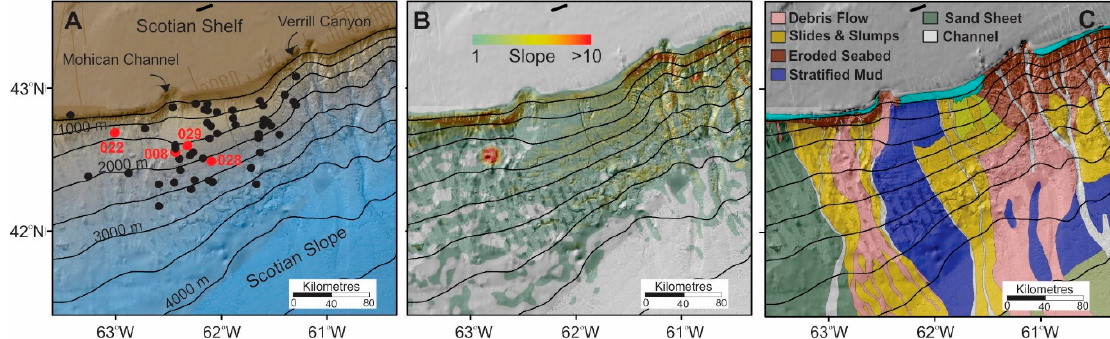
Figure 2. Study area: ( A ) Morphology and core site locations (dots) used in this study. Red dots indicate cores from which samples were extracted for triaxial shear testing. Isobaths are in meters water depth; ( B ) slope gradient derived from the GEBCO 2014 grid and averaged with a circular smoothing window with a radius of 12.5 km. Note that the general gradient of this central Scotian Slope region is on the order of 1–3; and ( C ) surficial geology derived from cores and interpretation of geophysical records [16,17]. North is to the top in each map.